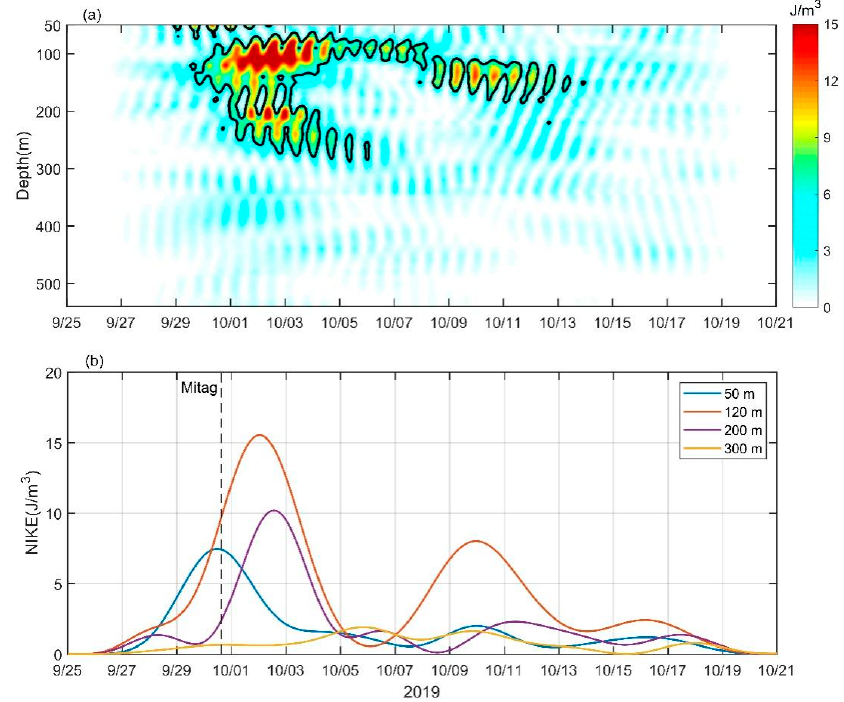
Figure 6. ( a ) Depth–time plot of near-inertial kinetic energy (NIKE) at the mooring; black contours mark the 5 J/m 3 NIKE. ( b ) Time series of one inertial period low-pass filtered NIKE at different depths; vertical black dashed line denotes the time when typhoon Mitag’s center was closest to the